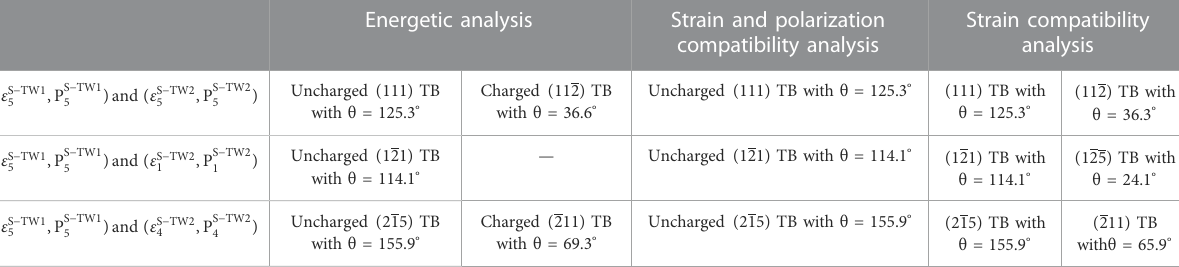
TABLE3 Comparisonofpredictionresultsbetweencompatibilityanalysisandenergeticanalysis.Notethatthetwinplanesarespeci fi edinthe x TW 1